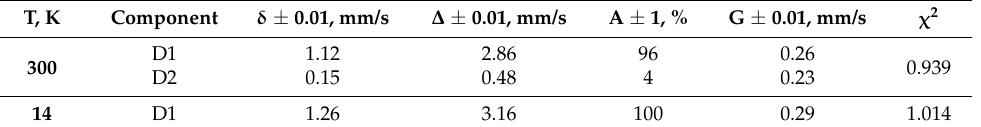
Table 4. Isomer shift ( δ , mm/s), quadrupole splitting ( ∆ , mm/s), component area (A, %), linewidth (G, mm/s), and Pearson’s criterion ( χ 2 ) for the Mössbauer spectrum of 3 at 14 and 300 K.